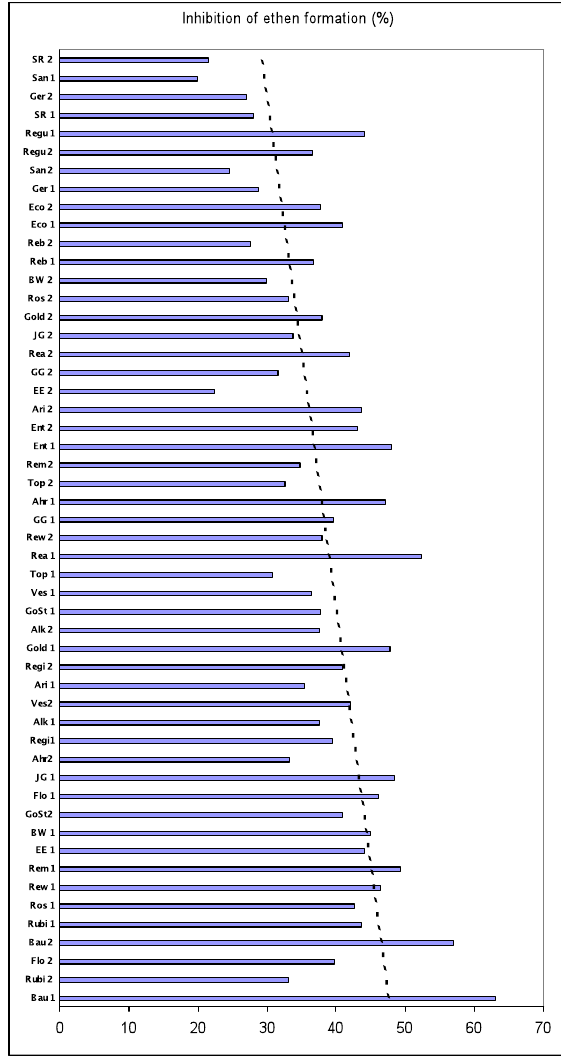
Fig. 3: Inhibition of ethene formation from KMB by apple juices (final con- centration in the assay 0.27 %V/V) in the X/XOD test (100% ethene formation from X/XOD/KMB: 8.5±0.8nmol). The samples are ar - ranged in the order of increasing “Total Flavanol concentration”. The dotted line marks the trend of increasing antioxidant activity with r 2 = 0.65.